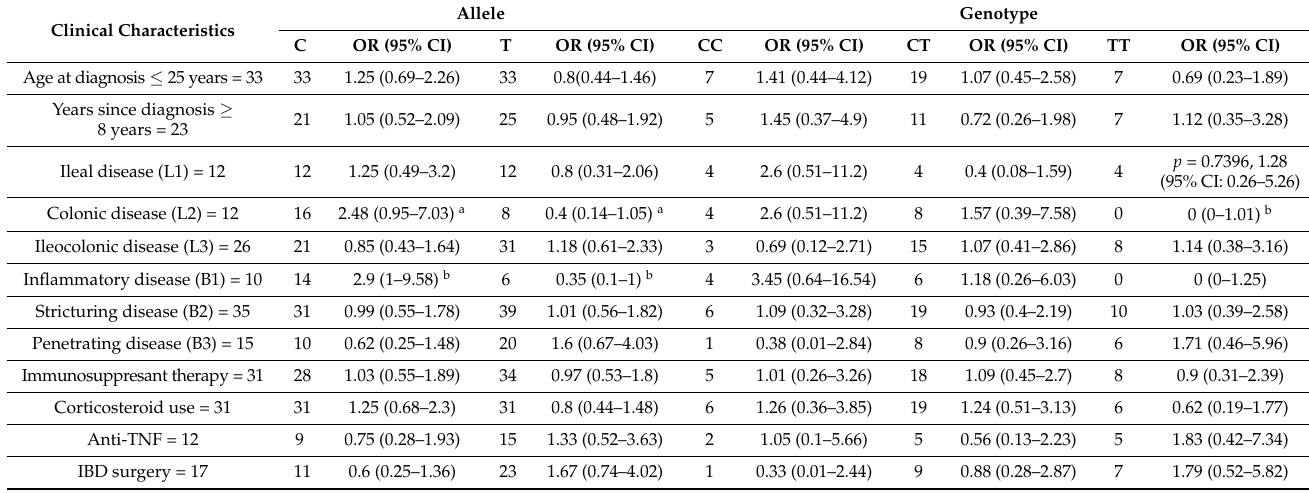
Table 4. Genotype–Phenotype Analysis for C3435T SNP in CD.